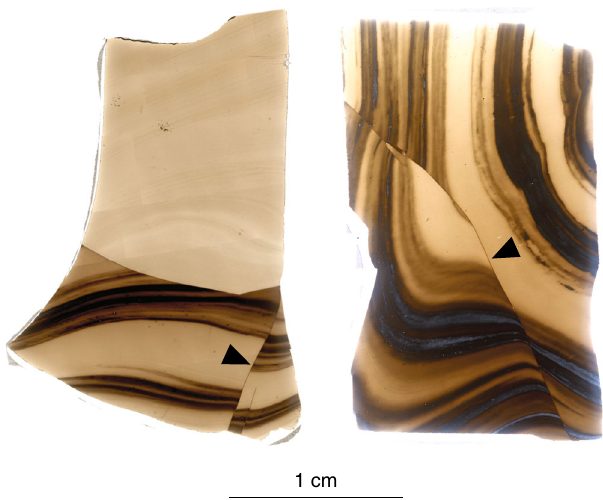
Fig. 1 Photomicrographs of obsidian from Hrafntinnuhryggur, Kra fl a volcano (Iceland) collected in situ toward the margins of an effusive dyke-geometry conduit 17 with textural evidence for fracture formation and subsequent healing while at high temperature (marked with arrows). These images were taken by Jenny